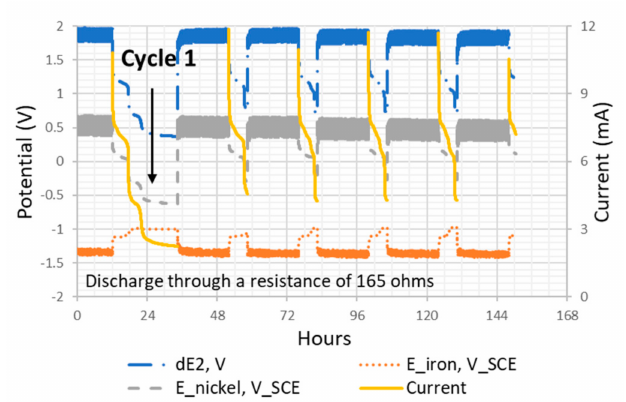
Figure 8. The potential and current profiles of the Ni–Fe cell with a 165 Ω resistor. The first discharge is enlarged and presented in Figure 9. Measurements include the potential difference between the cathode and anode (dE2), the potential of the iron plate as anode (E_iron, V_ SCE ), the potential of the Ni–CF cathode (E_nickel, V_ SCE ), and the current with a 165 Ω resistor. The arrow indicates the region of cycle one.